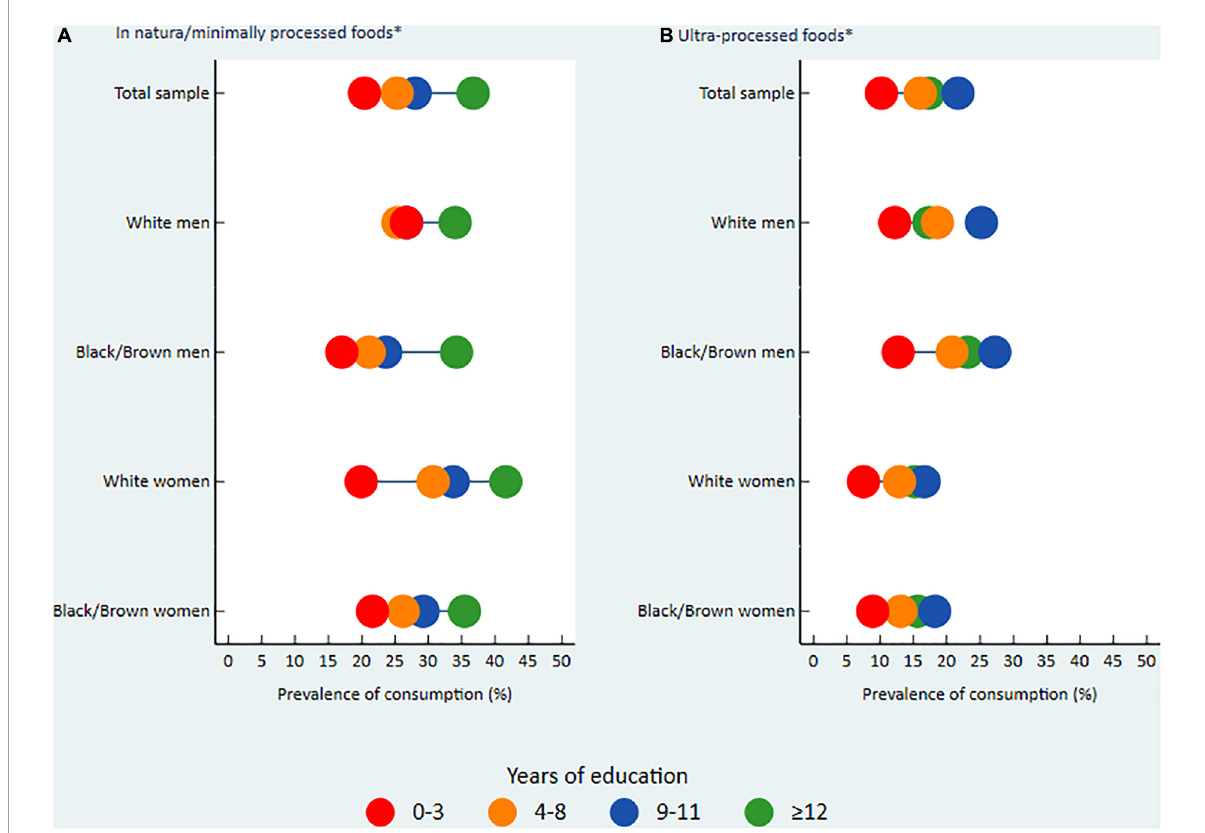
FIGURE1 Prevalence of consumption of in natura /minimally processed foods (A) and ultra-processed foods (B) in Brazil. a VIGITEL, Surveillance of Risk and Protective Factors for Chronic Diseases through Telephone Interviews. a Prevalence of consumption of each food group [ in natura /minimally processed foods (A) and ultra-processed foods (B) ], by years of education and intersection of sex and skin color/race, VIGITEL 2019 (equiplot). ∗ Consumption equal to or higher than 5 different foods from each food group, the day before the